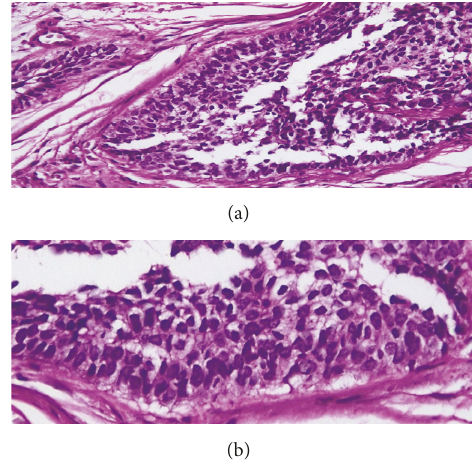
Figure 3: Adamantinoma-like EWS: prominent squamoid mor- phology with peripheral palisading. ((a) H&E X 200; (b) H&E X